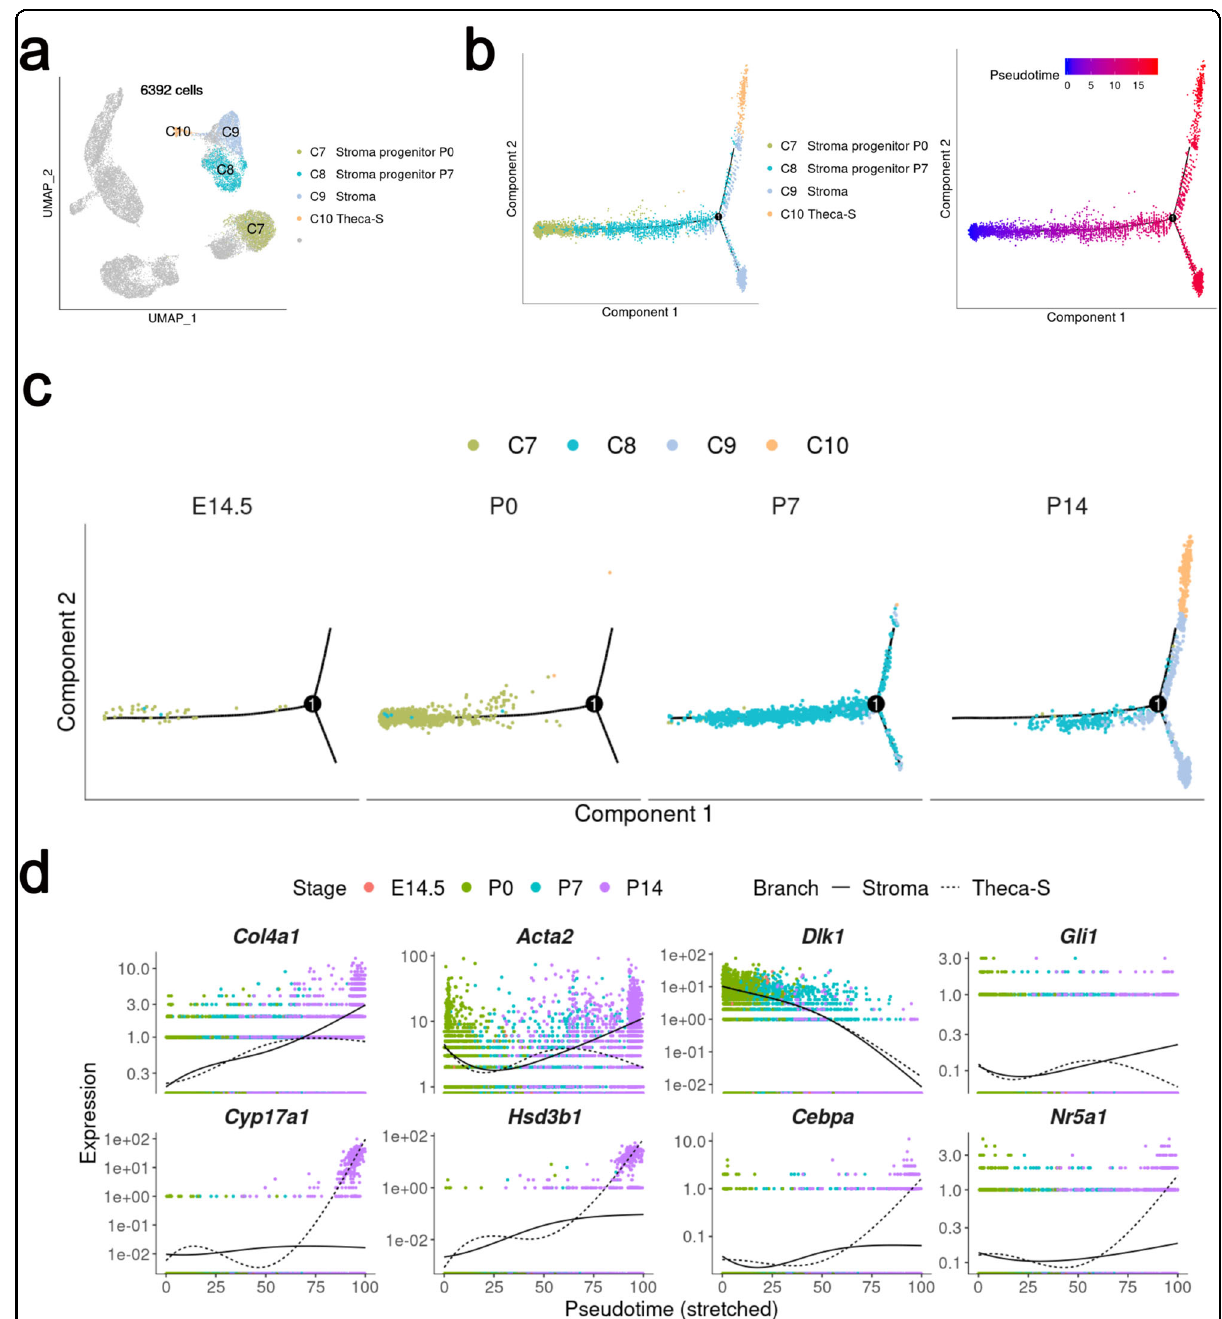
Fig. 6 Cell lineage and pseudotime prediction of the divergence of stromal and Theca-S lineages from a common progenitor population. a UMAP plot as shown in 3a , only the non-proliferating cells (C7 – C10, 6392 cells) were used for the following pseudotime analysis. b Pseudotime ordering of cells shown in a , with cells colored by cell clusters (left) and pseudotime (right). Color of pseudotime from blue to red, represented the cell states from naïve to mature. c Pseudotime trajectory plot from b (left) was split by sampling time points, with cells colored by indicated cell clusters. d Pseudotemporal kinetics plots showed the highly expressed genes in stromal and Theca-S